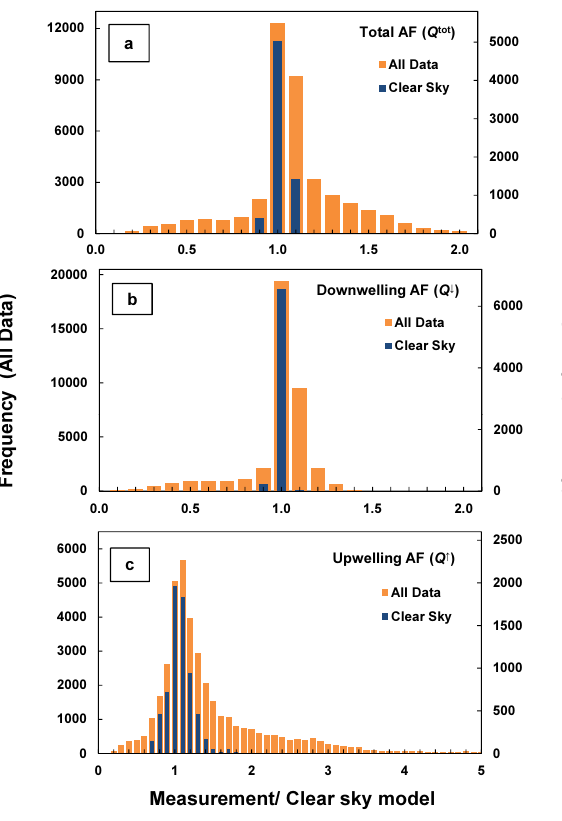
Fig. 3. Frequency distribution of the measurement/model ratios for (a) total, (b) down-welling, and (c) up-welling actinic flux. Blue bars are for cloud-free skies, orange bars for all sky conditions. Fig. 4. Altitude variation of the ratio of observed to cloud-free